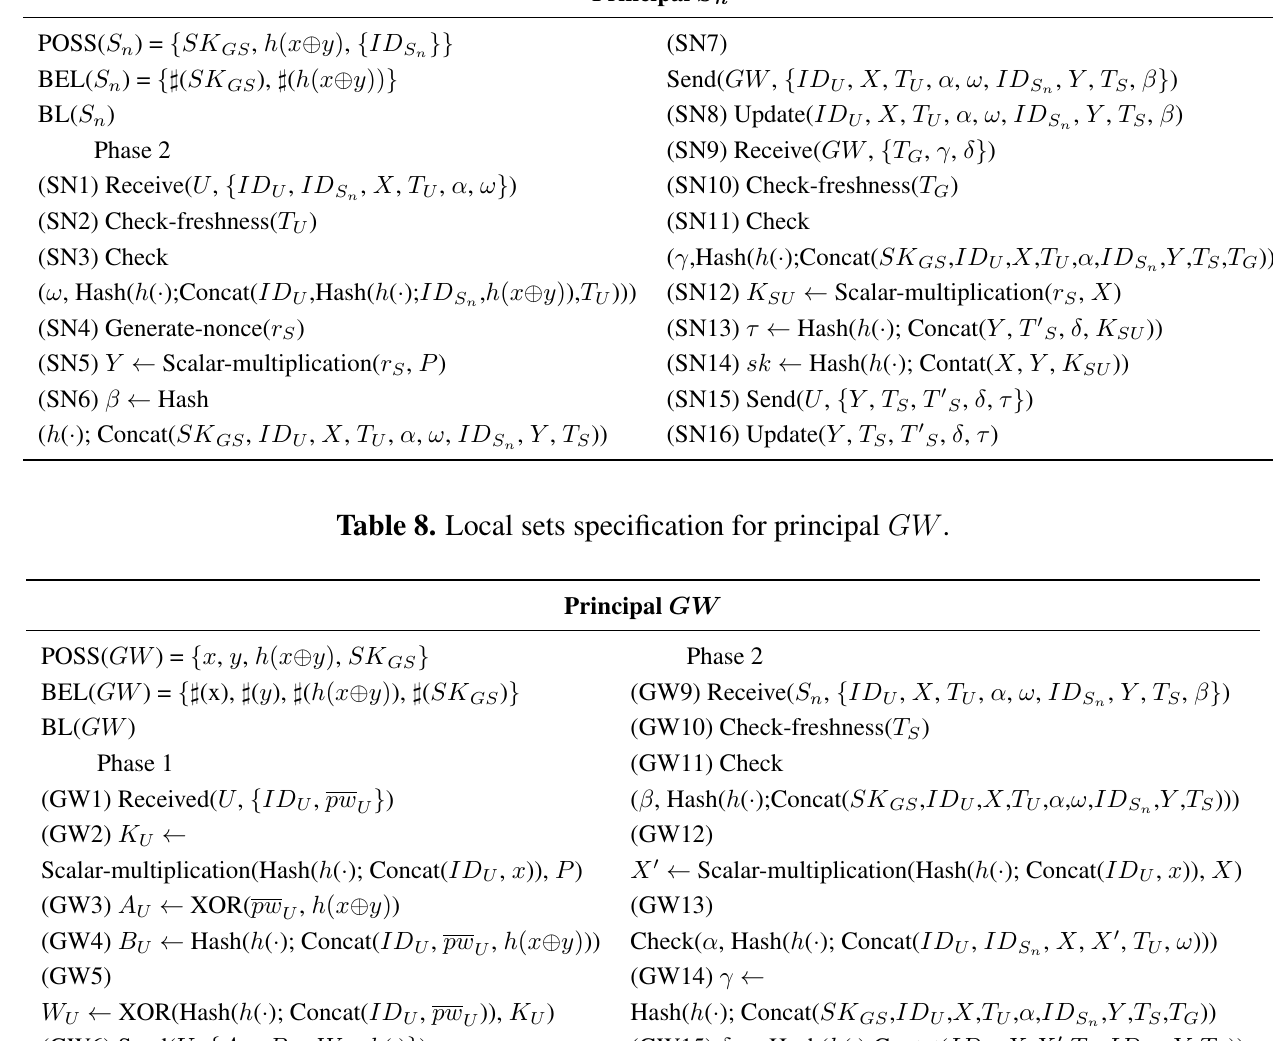
Table 7. Local sets specification for principal S